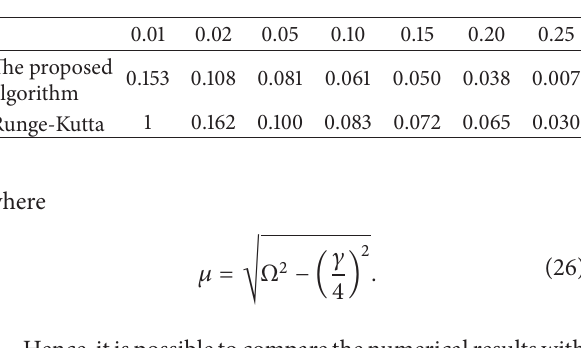
Table 2: The normalized CPU time for different step sizes Δ𝑡 and methods.